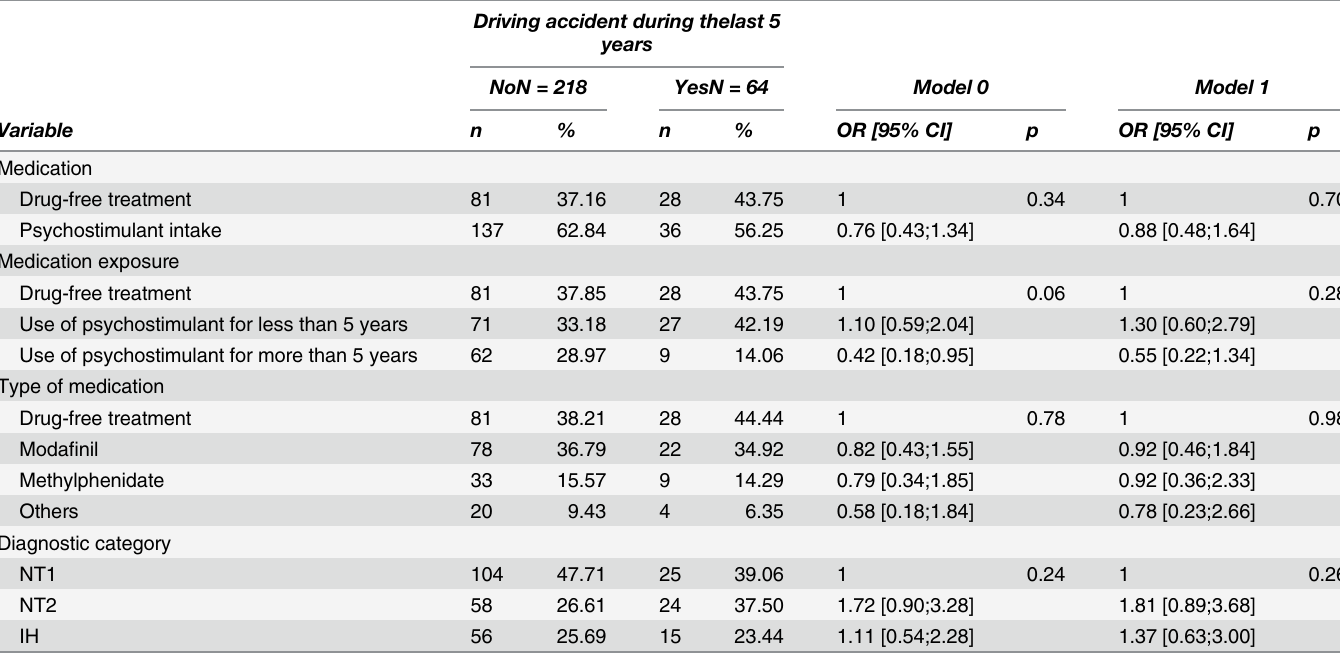
Table 5. Between-group comparisons for the driving accident during the last 5 years among patients with central disorders of